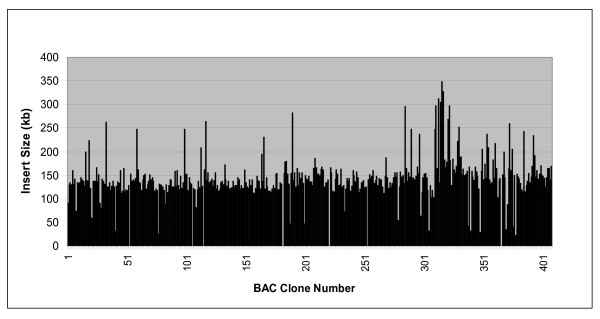
Insert size distribution of the 408 sampling BAC clones. The 408 sampling BAC clones were selected by picking one clone from A01 position of every other 384-well plate of the library and arranged in the same order of the library plates. Vertical bars indicate the sampling clones with inserts. The clones that failed to yield DNA or do not contain inserts are represented by blanks.